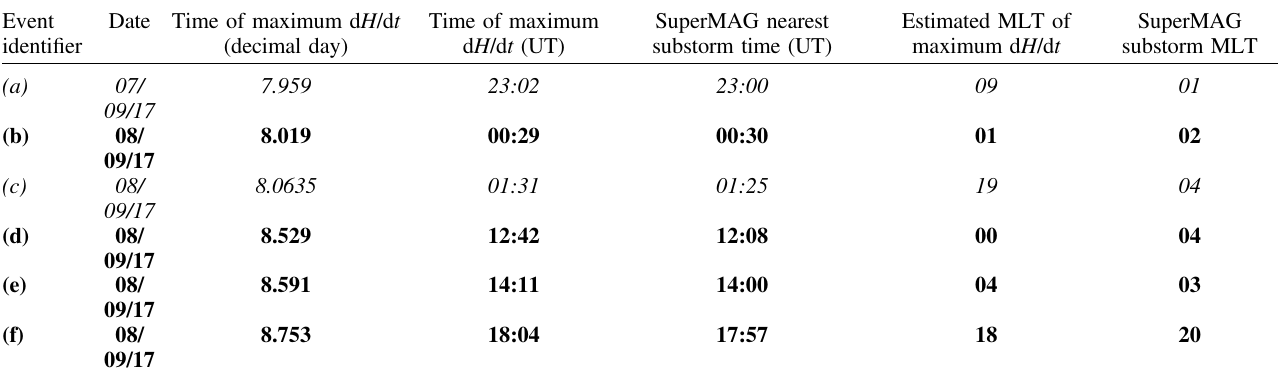
Table 2. Details of the events identi fi ed in Figures 3 and 4. The time of the maximum d H /d t for each event is compared with the nearest substorm event listed in the SuperMAG database (as of 18 September 2020), as well as the MLT. Events with MLT values separated by <4 h are identi fi ed by bold text, while events with MLT values separated by >4 h are identi fi ed in italics.